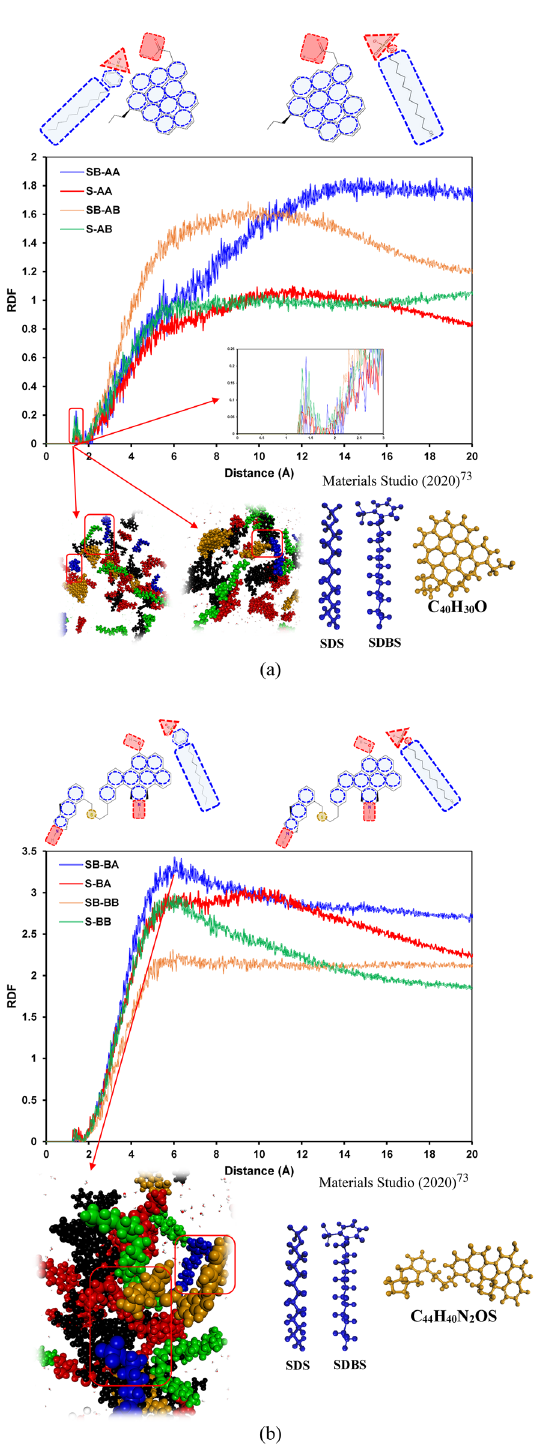
Figure 5. RDFs of the asphaltene–surfactant molecule pairs containing ( a ) C 40 H 30 O 2 and ( b ) C 44 H 40 N 2